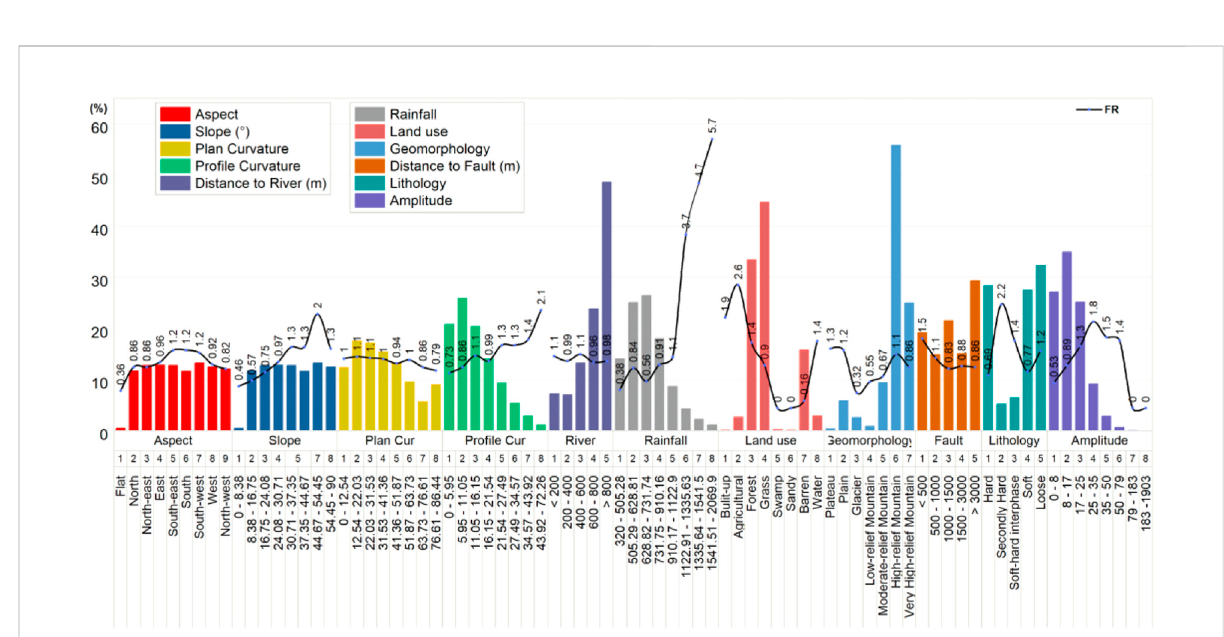
FIGURE 5 Statistical distribution and frequency ratio (FR) values of conditioning factors.